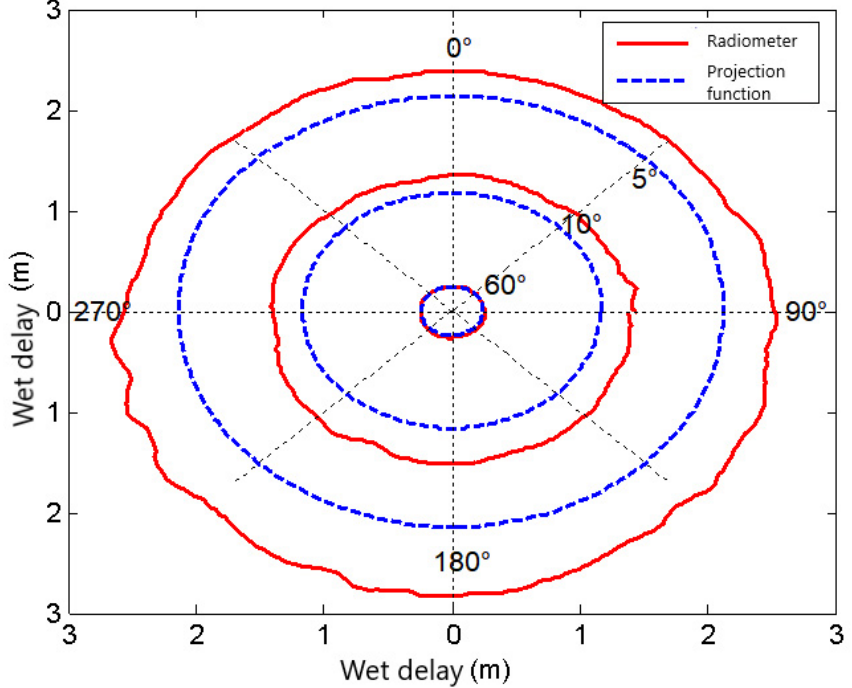
Niell projection function (hereafter referred to as the projection function wet-delay value).